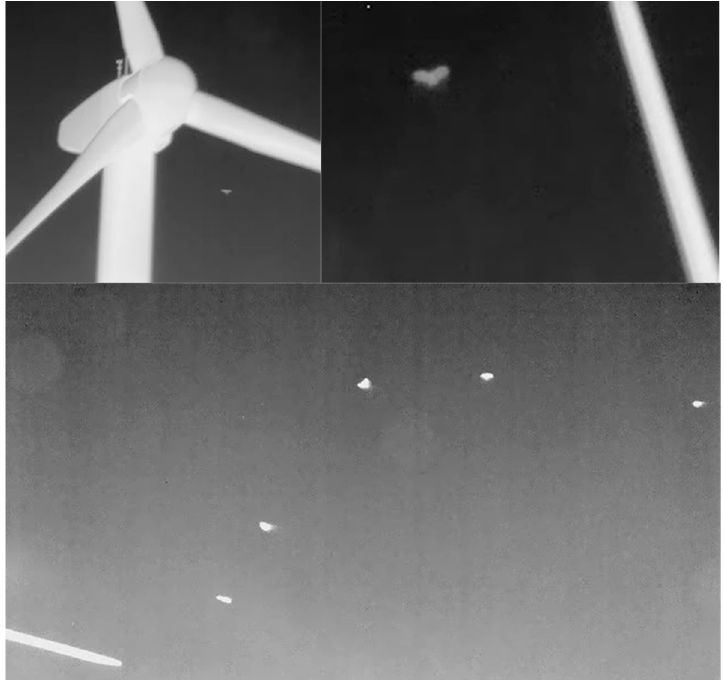
Figure 3. Bats observed near wind turbines, all of which we assumed were hoary bats based on size, behavior, and frequent discovery of hoary bat fatalities at Buena Vista and Golden Hills Wind Energy projects in California. The lower photo shows 5 hoary bats approaching a 1 MW Mitsubishi wind turbine.